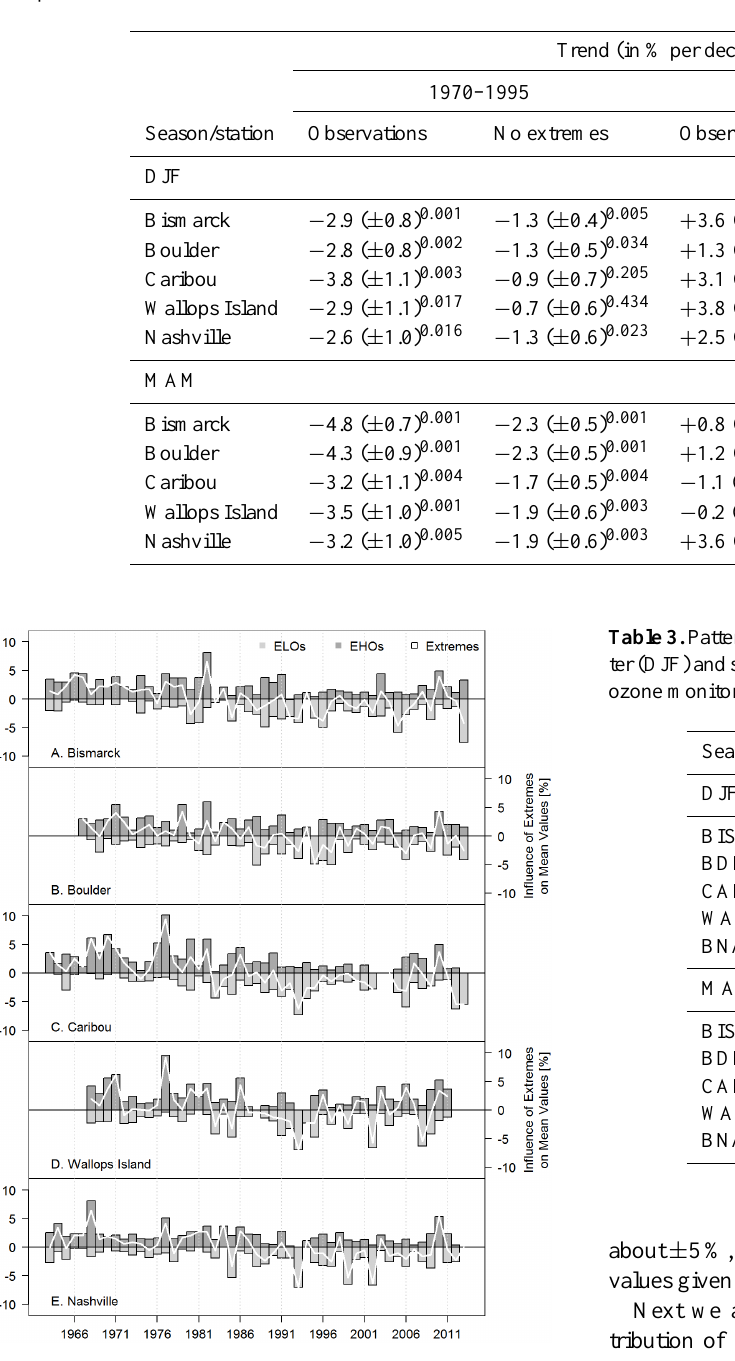
Table 2. Seasonal linear trends (in % per decade) for observed and extremes removed winter (DJF) and spring (MAM) column ozone time series in 1970–1995 and 1996–2010 at the five US ozone monitoring sites. Standard errors are given in parentheses; p values are provides as superscripts.